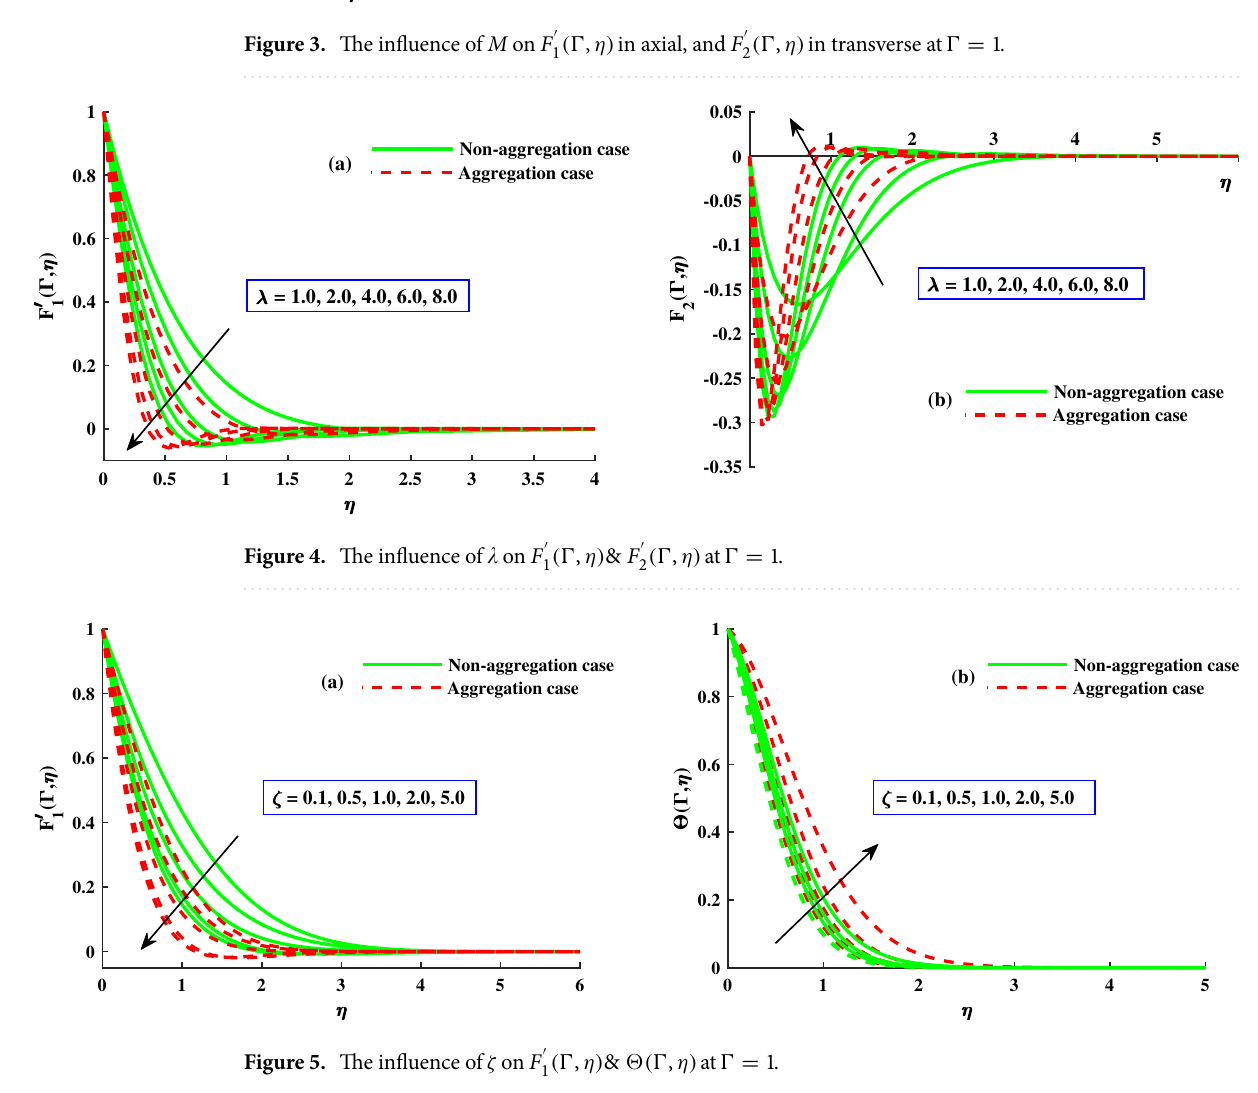
Figure 3. The influence of M on F ′ 1 (Ŵ , η) in axial, and F ′ 2 (Ŵ , η) in transverse at Ŵ